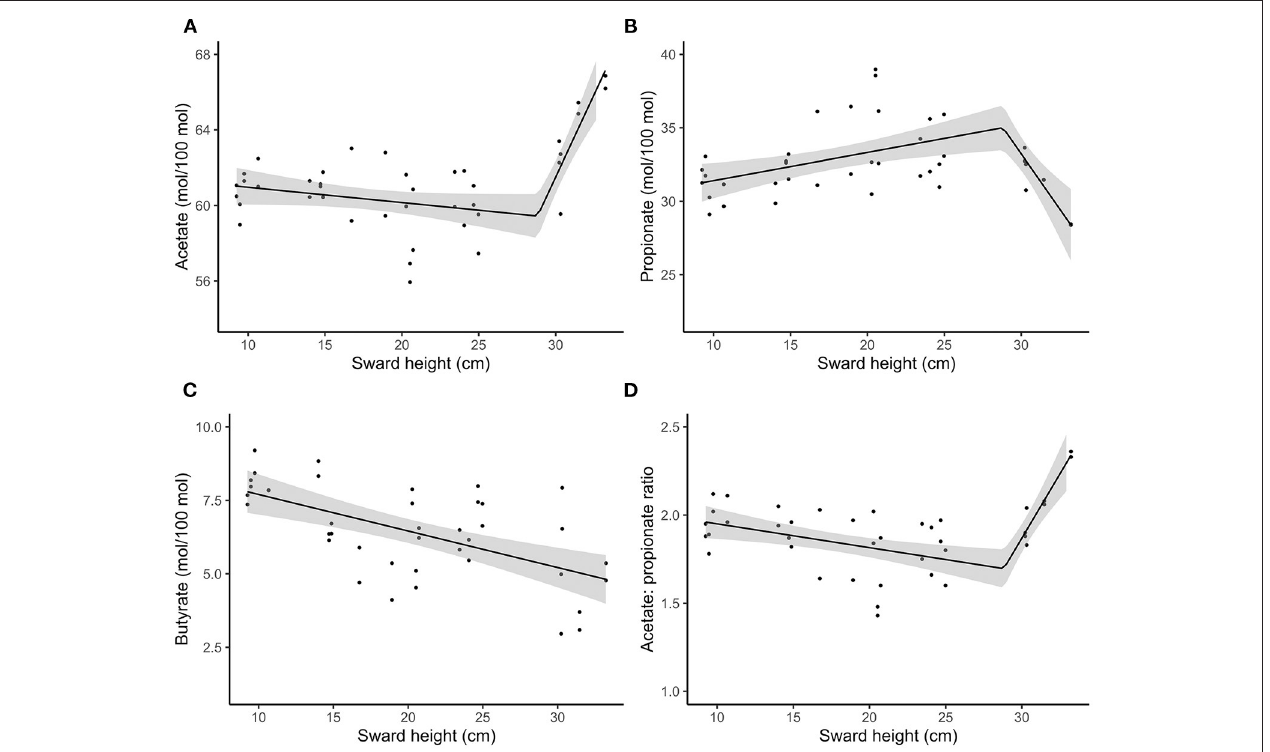
FIGURE 4 | Relationship between VFAs (mol/100mol) and acetate to propionate ratio with sward height (SH, cm) of kikuyu grass following 48h of fermentation. Equation for: Acetate = min [59.33–0.09 (SH − 28.4)], [59.33 + 1.55 (SH − 28.4)], p < 0.0001, R 2 = 0.54, (A) ; Propionate = min [35.04 + 0.20 (SH − 28.42)], [35.04–1.34 (SH – 28.42)], p < 0.001, R 2 = 0.30, (B) ; Butyrate = 8.94–0.12SH, p < 0.0001, R 2 = 0.34, (C) ; and Acetate: propionate ratio = min [1.70–0.013 (SH − 28.8)], [1.70 + 0.14 (SH − 28.8)], p < 0.0001, R 2 = 0.44, (D)